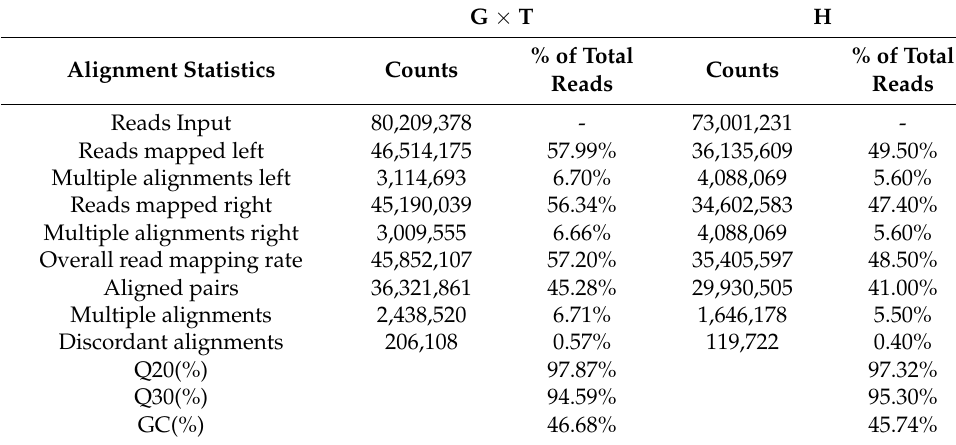
Table 1. Summary of sequence analysis and